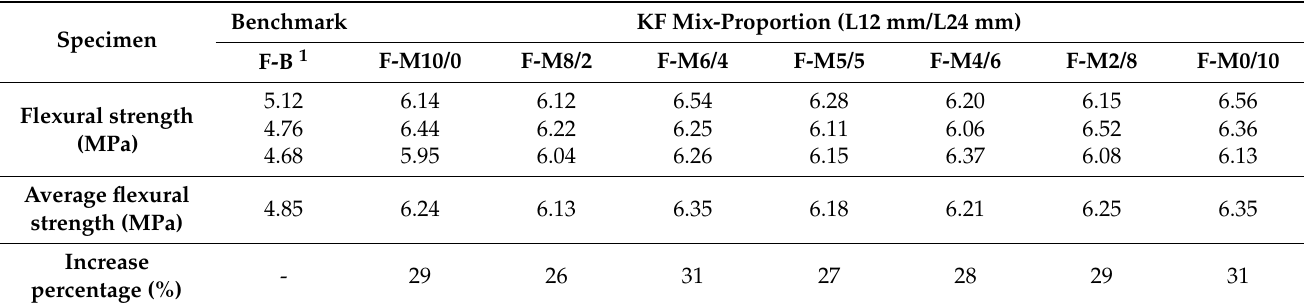
Table 9. Flexural strengths of the benchmark and mix-proportion KFRC specimens.